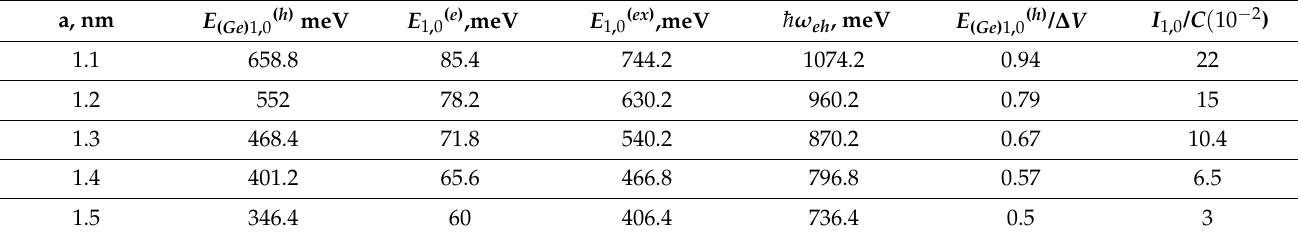
Table 1. Dependences of energy E 1,0 ( ex ) ( a ) (10) of the spatially indirect excitons (SIE) ground state (variational calculation) (expressed by meV), energy E ( Ge ) 1,0 ( h ) ( a , ∆ V ) of a hole (expressed by meV) (obtained using Formulas (15)–(18)), and energy E 1,0 ( e ) ( a ) ( 11 ) of an electron (expressed by meV), energy (cid:125) ω ex ( a ) (22) of an electron transition (expressed by meV), and radiation intensity ( I 1,0 ( a ) / C ) (24), as a function of the mean radius a (expressed by nm) QD germanium. ∆ V = 700 meV is the depth of the potential well for holes in the germanium